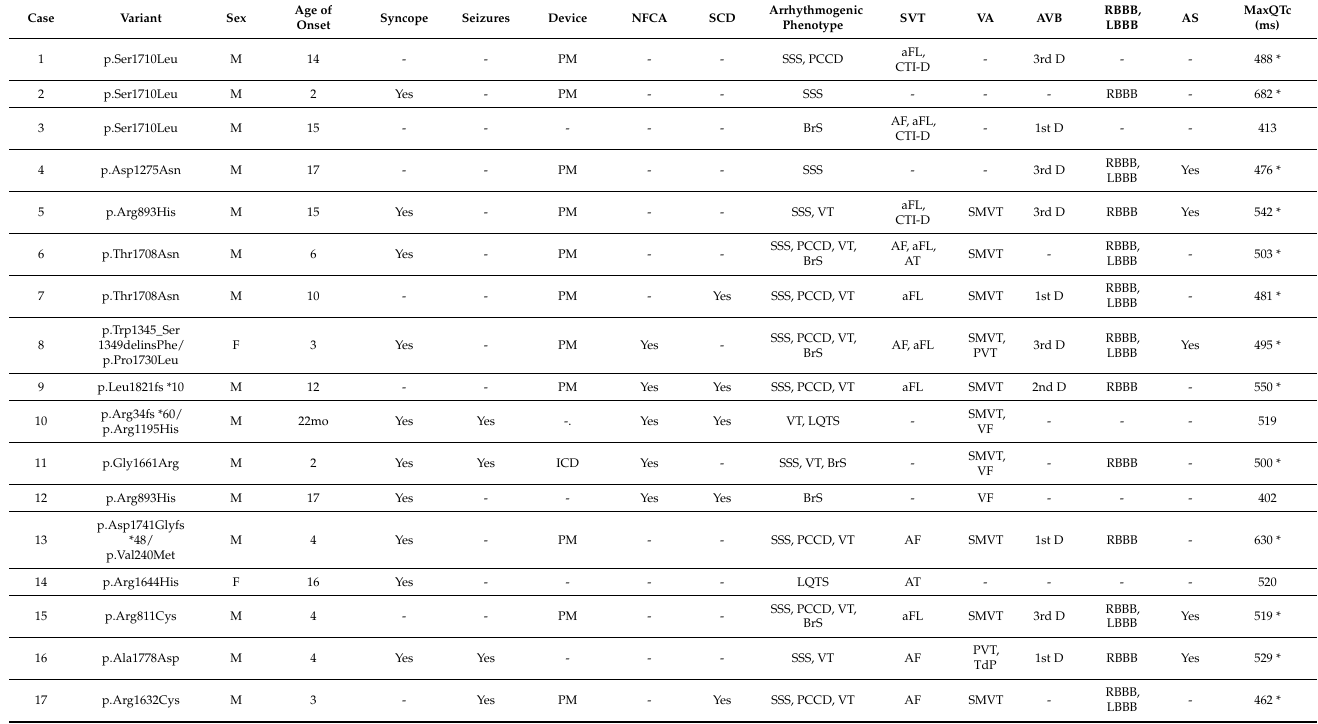
Table 2. Clinical characteristics of SCN5A -channelopathy pediatric